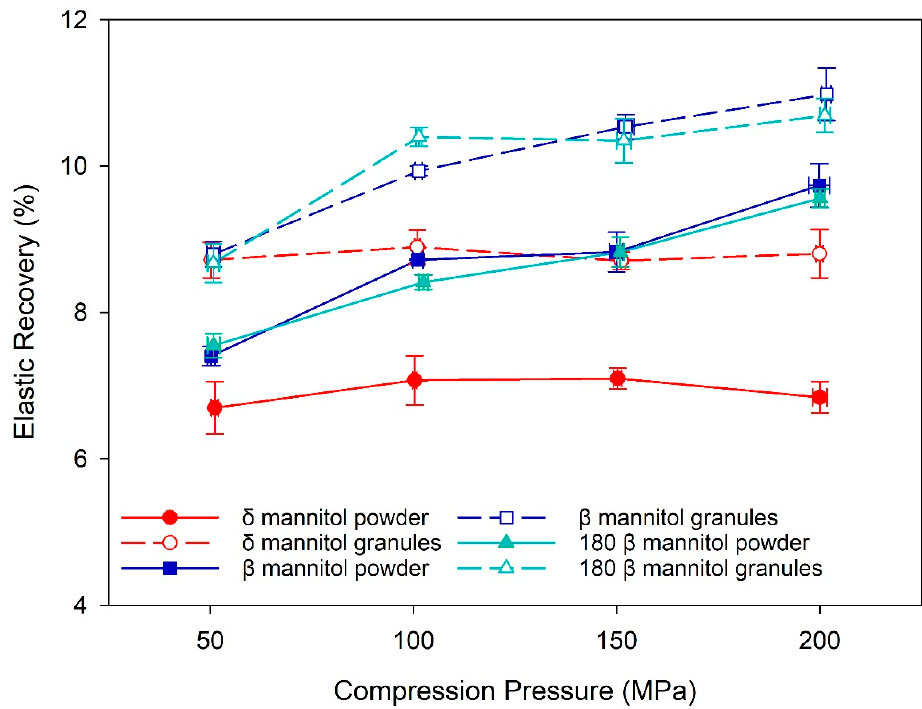
Figure 6. The percentage of elastic recovery for δ mannitol, β mannitol, and 180 µm sieved β man- nitol powder and granules. Arithmetic means of n = 10 ±